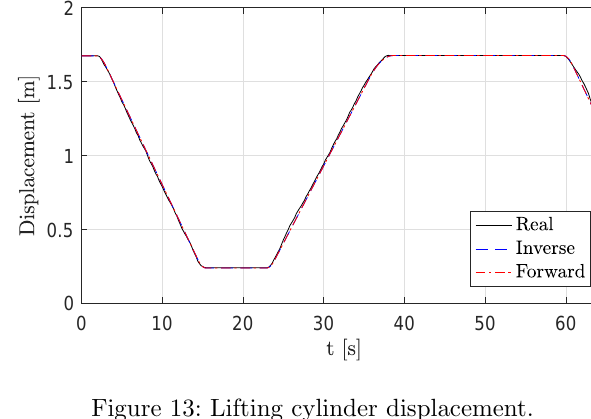
Figure 13: Lifting cylinder displacement.